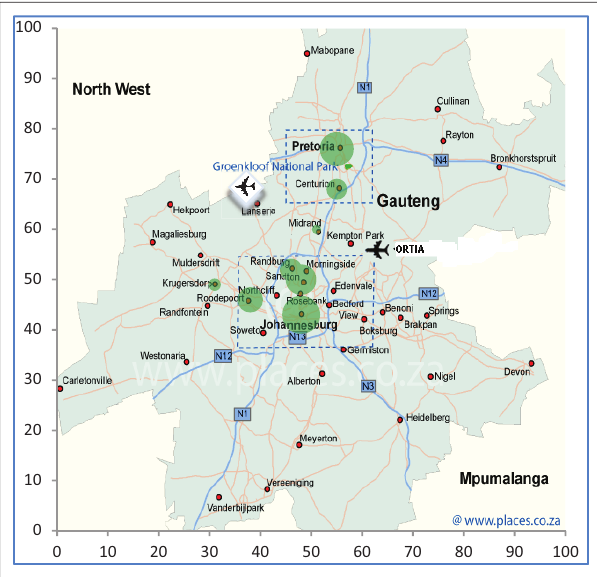
FIGURE 3: Gauteng respondents’ residential distribution